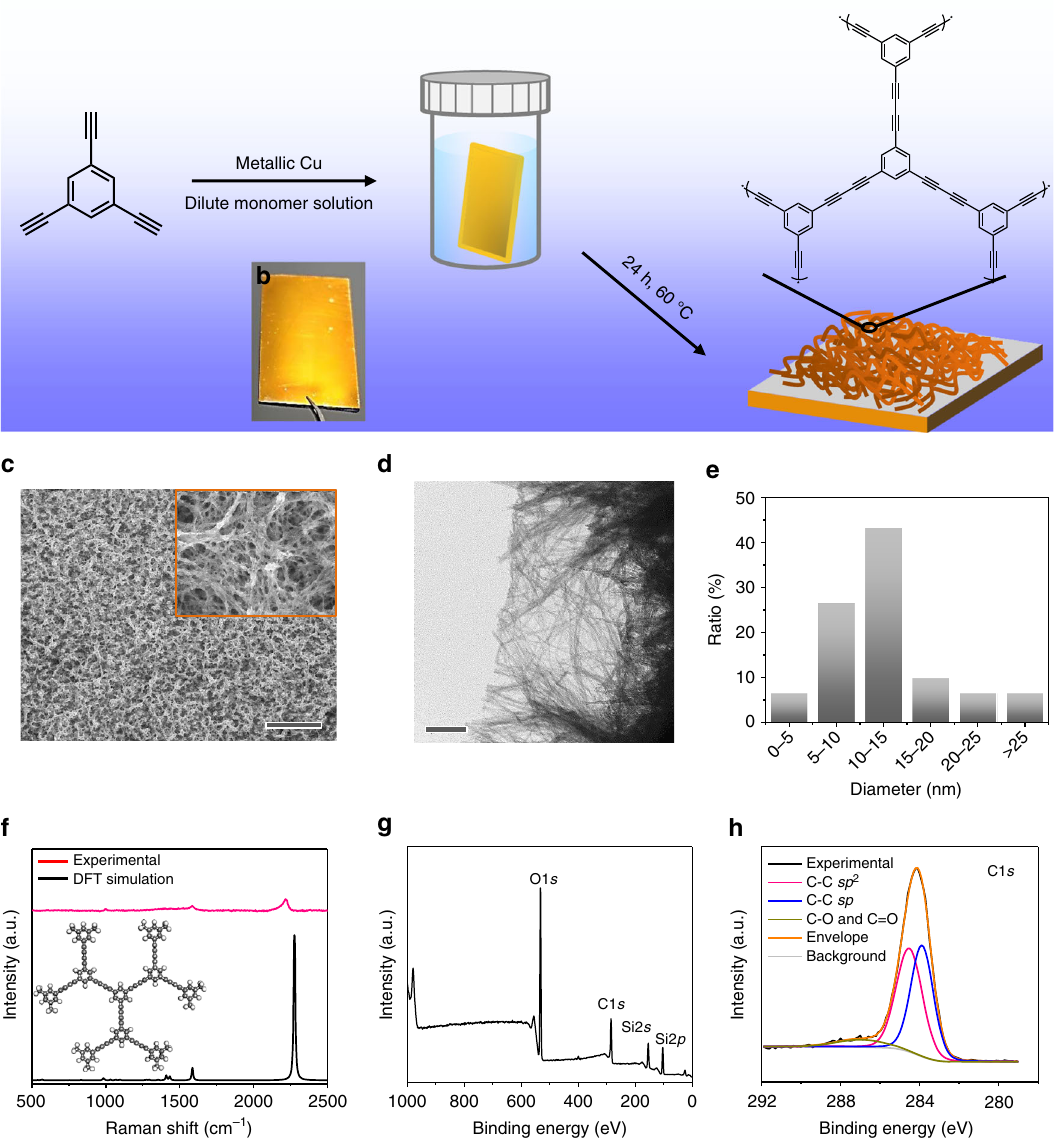
Fig. 1 Synthesis and characterization of PTEB nano fi bers. a Reaction scheme and employed molecules. b Photograph of the PTEB layer synthesized on a Cu wafer. The coupling reaction occurs only at the Cu – liquid interface, resulting in the selective formation of PTEB netwrok on Cu surface. c Scanning electron microscopy (SEM) images of PTEB nano fi bers at Cu surface, scale bar: 10 µ m. Inset: magni fi cation of c . d Transmission electron microscopy (TEM) image of PTEB grown on a Cu grid, scale bar: 200 nm. e Histogram of the diameter of the PTEB nano fi bers measured from d . The agreement between the Raman spectra obtained from f the experiment and density functional theory (DFT) calculations con fi rm the generation of diacetylenic linkages in PTEB. g XPS survey spectrum and h high-resolution C1s core level spectrum of PTEB on a SiO 2 /Si wafer. The fi tting in h was performed with a set of Voigt